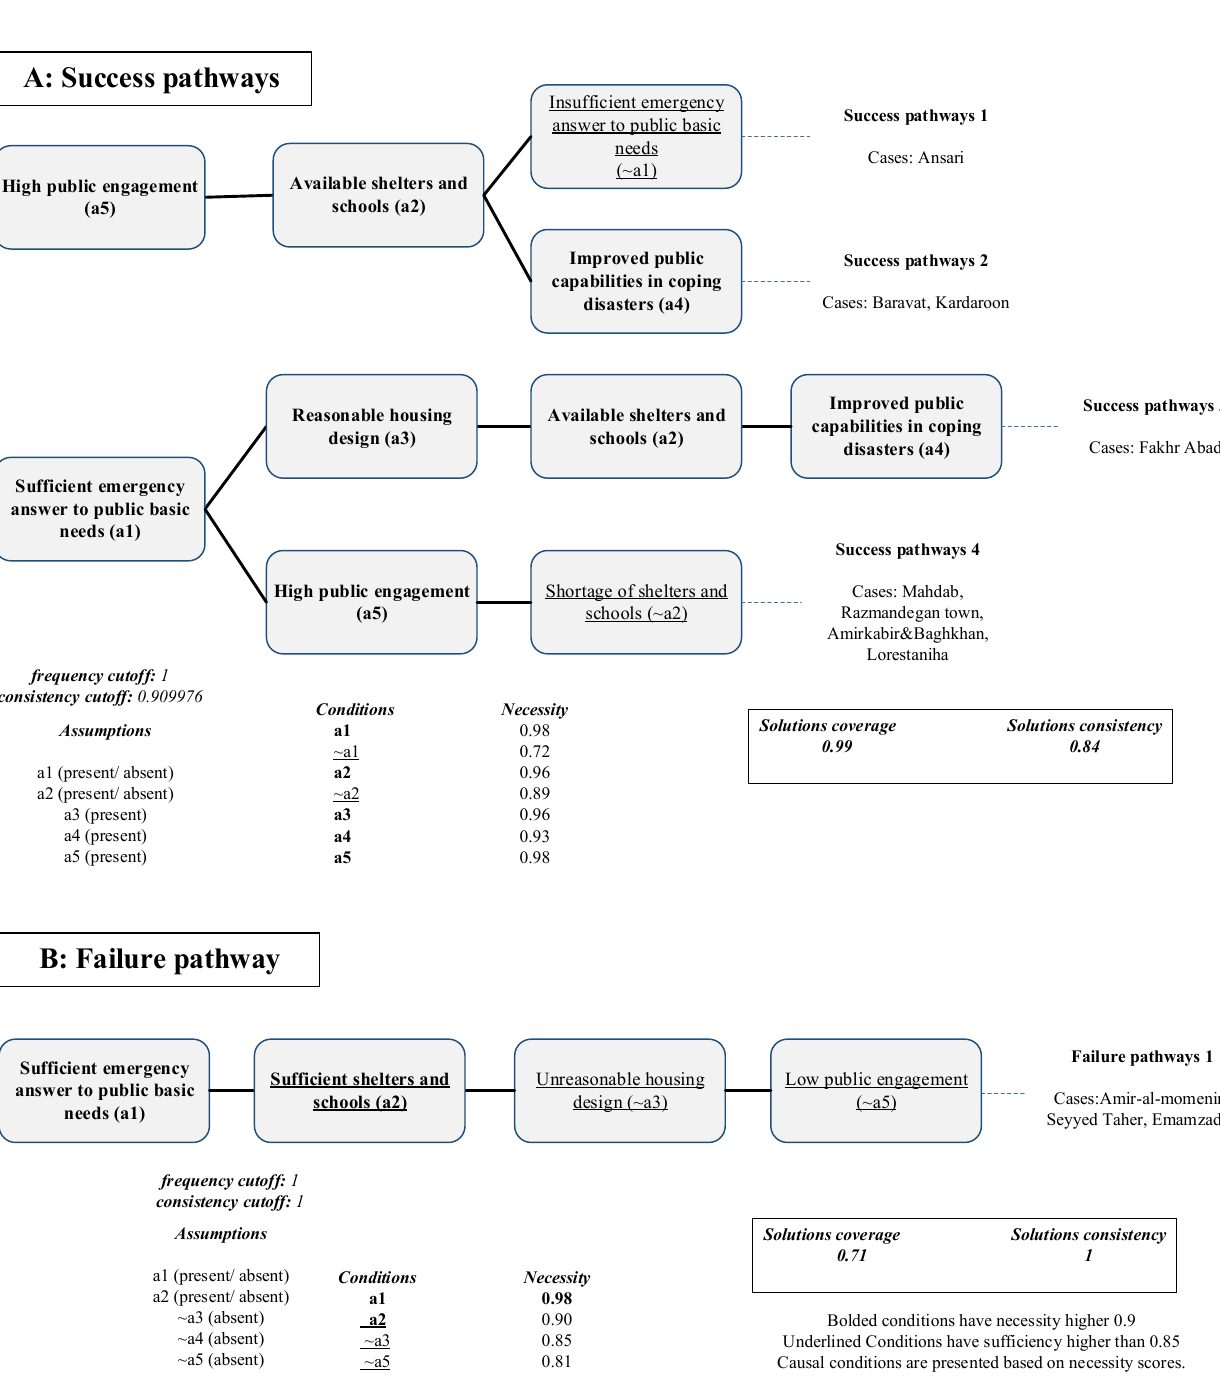
Figure 6. Success and failure pathways for outcome A2.